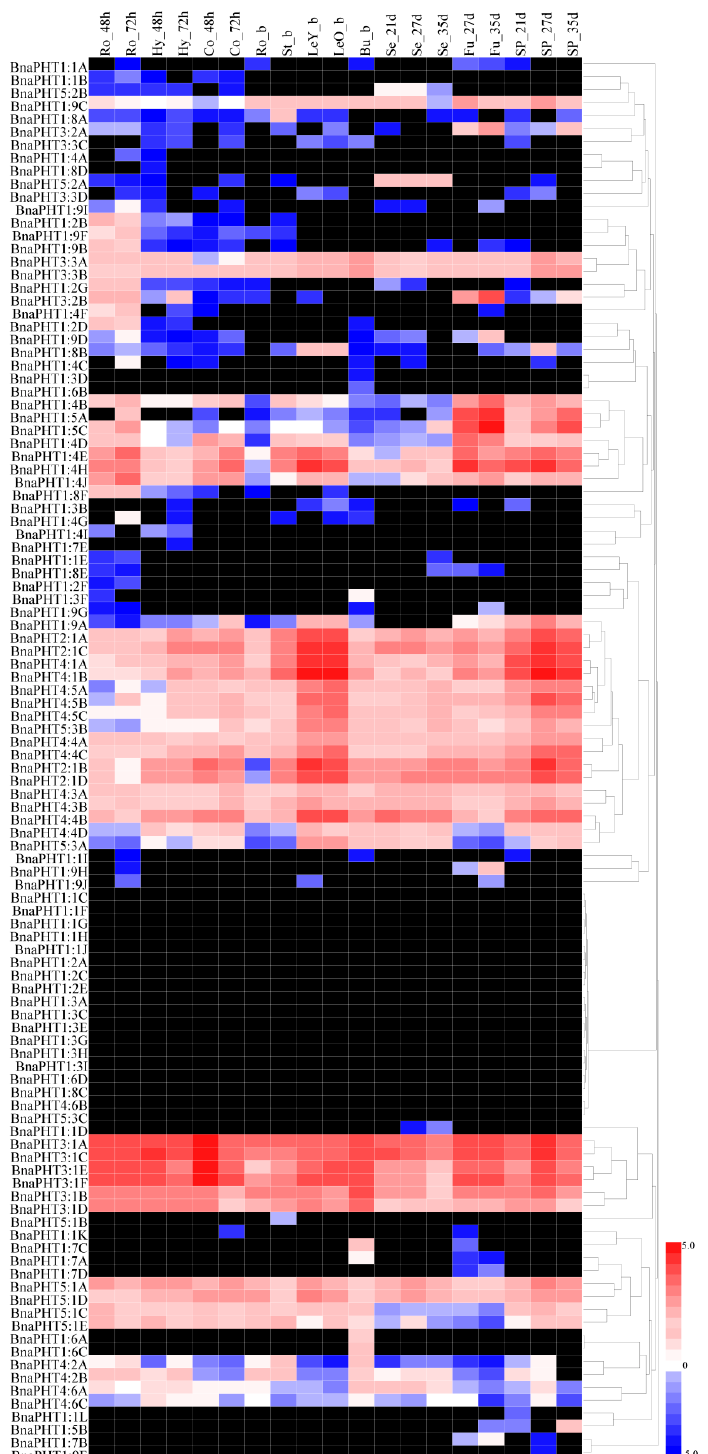
Figure 5. Heatmap of the expression profiles of BnaPHT family genes in di ff erent tissues and organs. The abbreviations above the heatmap indicate the di ff erent tissues and organs / developmental stages of B. napus ZS11 (Table S3). The expression data were obtained from RNA-seq data and are shown as log2 values, as calculated based on FPKM values (fragments per kilobase of exon model per million). The heatmap was generated using Heatmap Illustrator 1.0 (HemI 1.0). The black indicates that the BnaPHT had no expression (FPKM = 0) levels in this study (Table